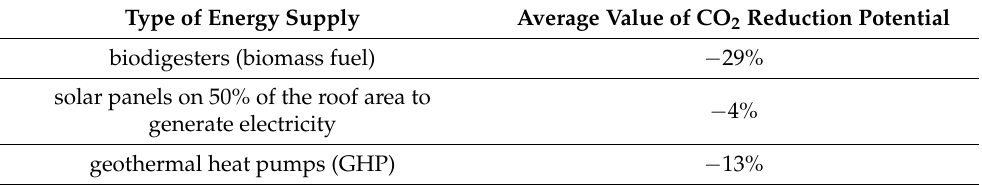
Table 7. Summary of quantitative calculations of the relationship between renewable energy and carbon reduction